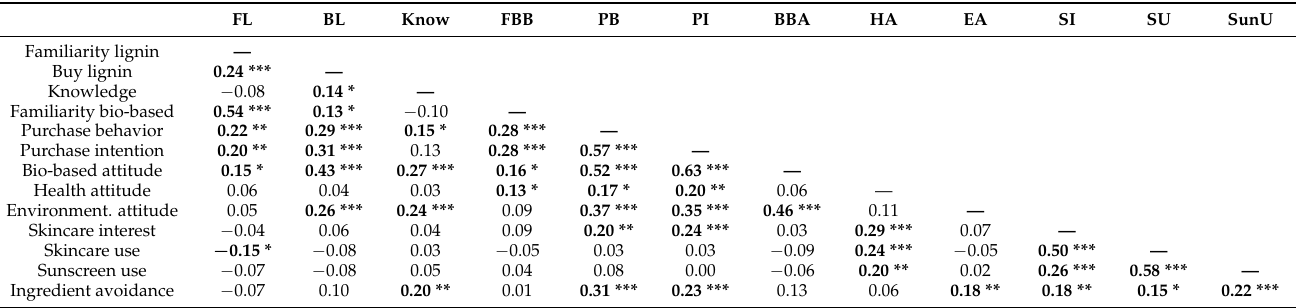
Table 3. Spearman r s